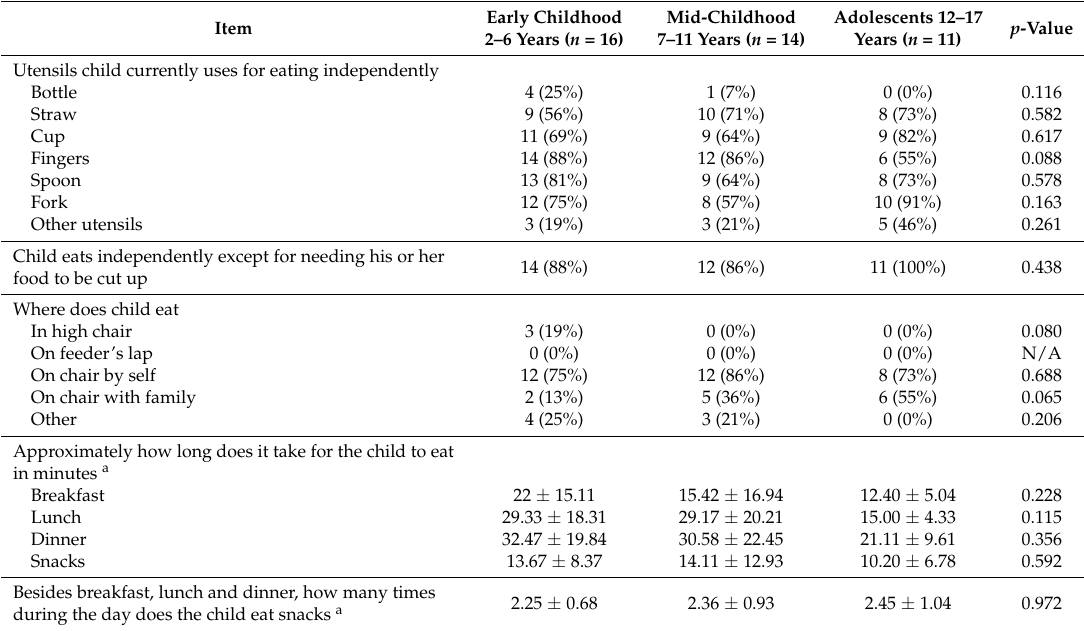
Table 3. Mealtime environment by age